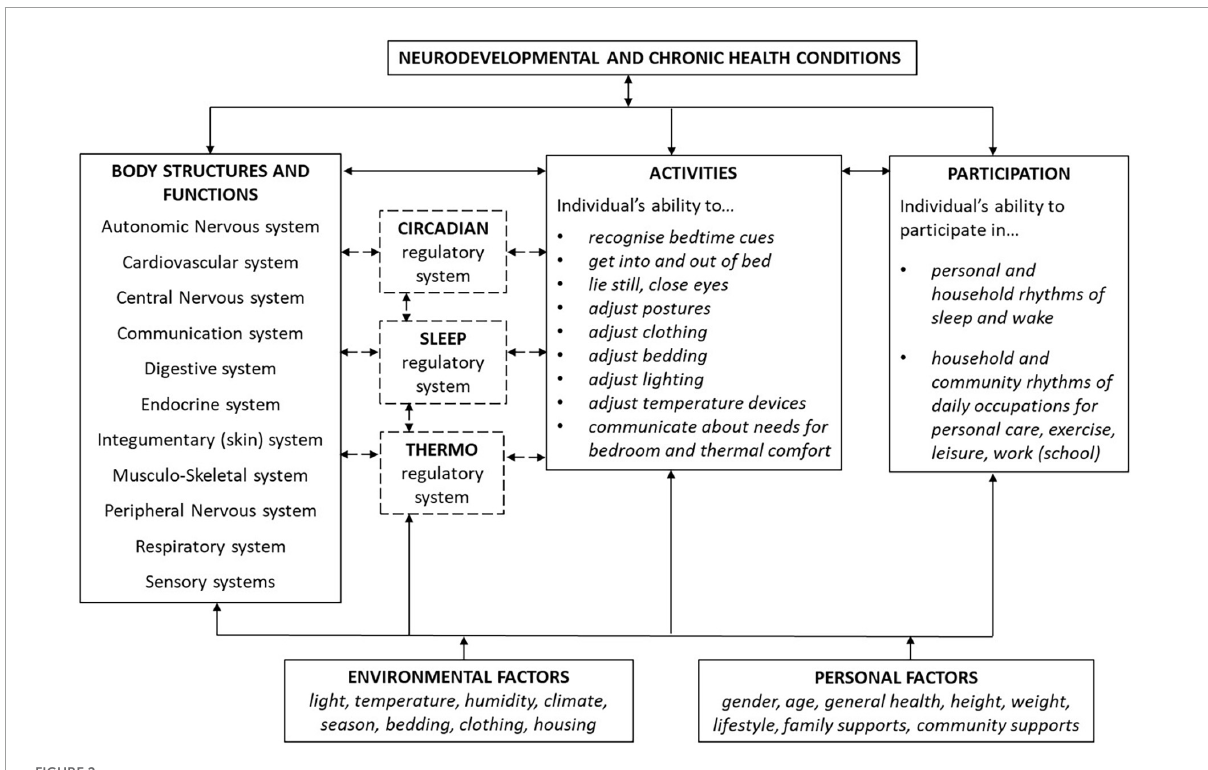
FIGURE2 Thermoregulation and sleep in context of the